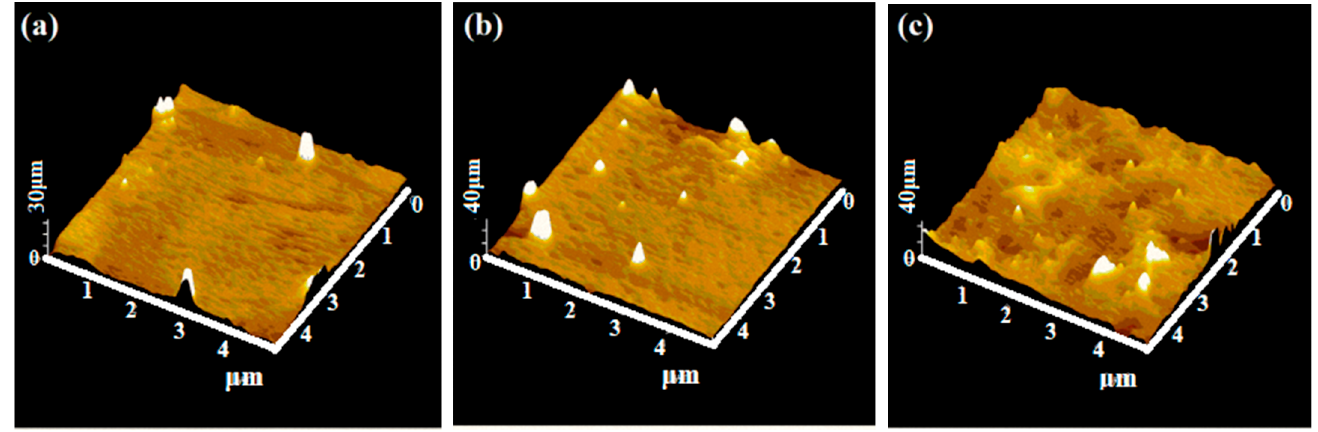
Figure 11. AFM topographies of ( a ) TPFPU-1, ( b ) TPFPU-4 and ( c ) TPFPU-7. Table 3. Roughness parameters of the TPFPU latex films.